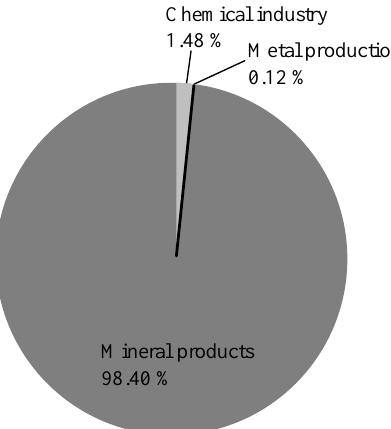
Fig. 1. GHGs emissions from the industrial sector in Thailand in 2011, 18.23 Mt CO 2 eq.